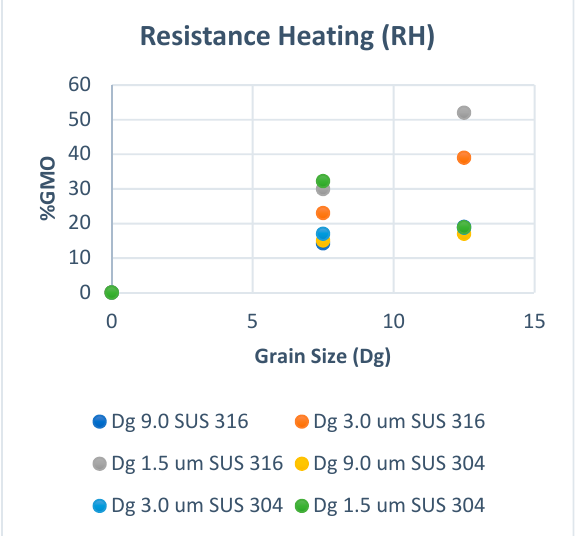
Figure 7. The FGMO with resistance heating (RH).